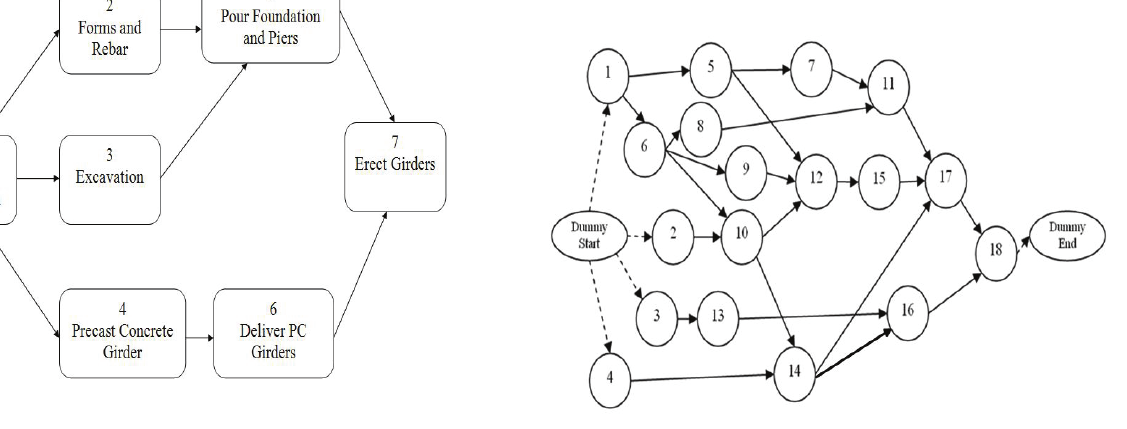
Fig. 7. Network of first case study